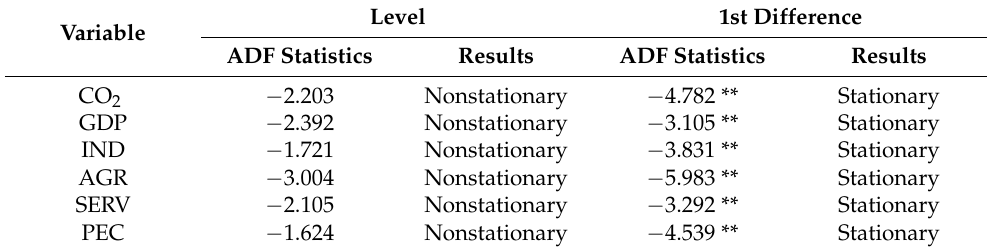
Table 1. Unit root results.